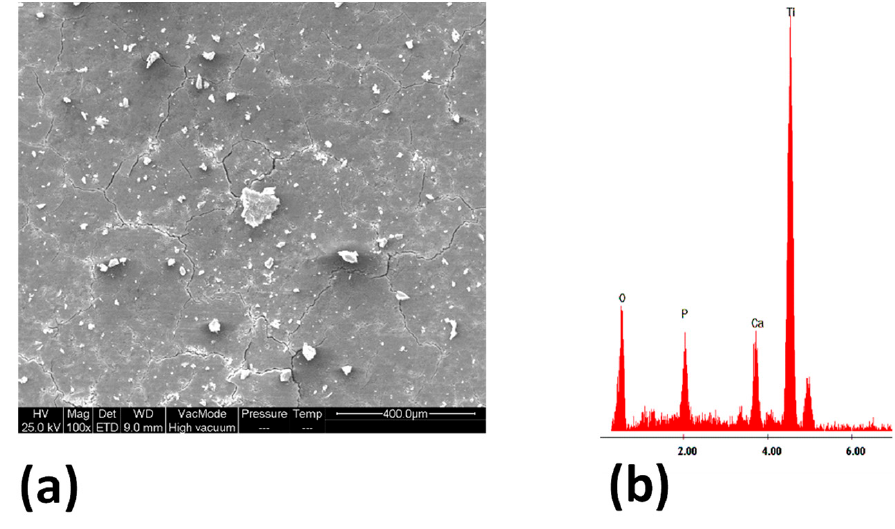
Figure 8. (a ) SEM micrographs and ( b ) EDS of a TiO 2 /PCL gel sample soaked in SBF for 21 days.